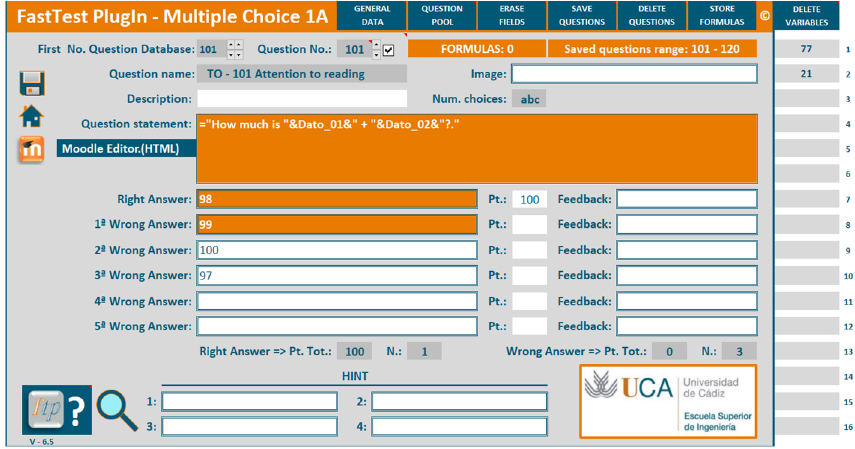
Figure 4. Example of a parameterised question with numerical values.